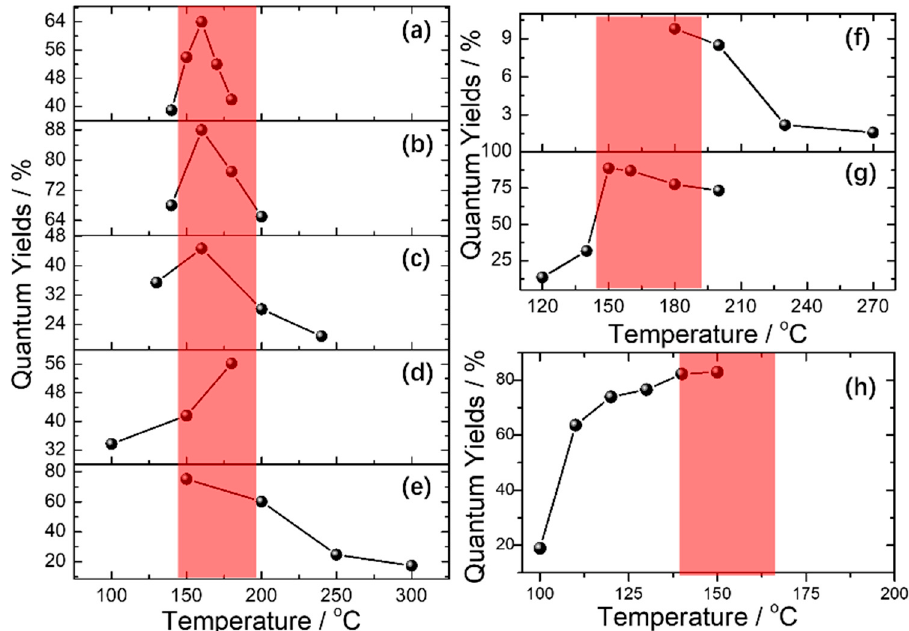
Figure 2. Temperature vs. quantum yields of carbon dots (CDs) synthesized from citric acid (CA) by ( a – e ) hydrothermal method, ( f , g ) thermal decomposition, and ( h ) microwave treatment. The data in ( a – h ) are organized according to the results in Ref. [29], Ref. [30], Ref. [31], Ref. [32], Ref. [6], Ref. [33] Ref. [25], and Ref. [34], respectively.